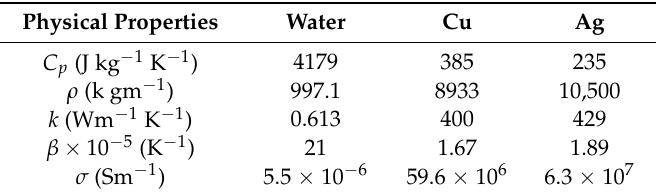
Table 1. Thermophysical properties of base fluid and